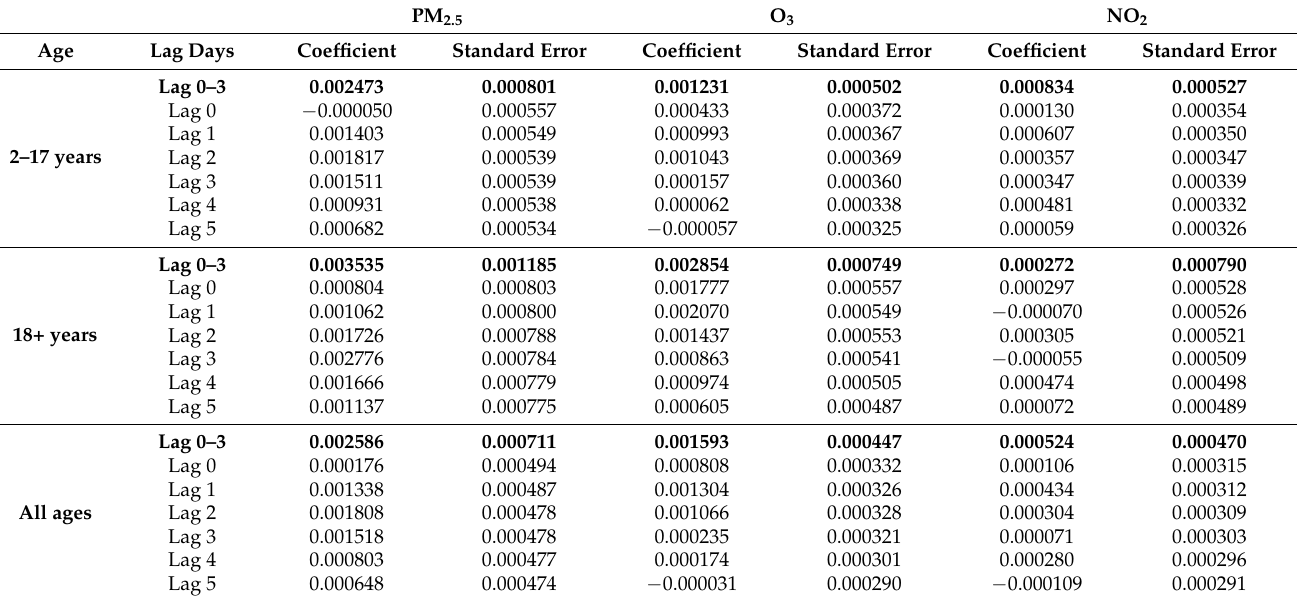
Table A3. Coefficients and standard errors of respiratory emergency department visits in Mexico City associated with key pollutants, by age group and lag structure. Coefficients for lag days 0–3 for PM 2.5 , O 3 , and NO 2 , for individuals of all ages, were used in the creation of the final validated air pollution